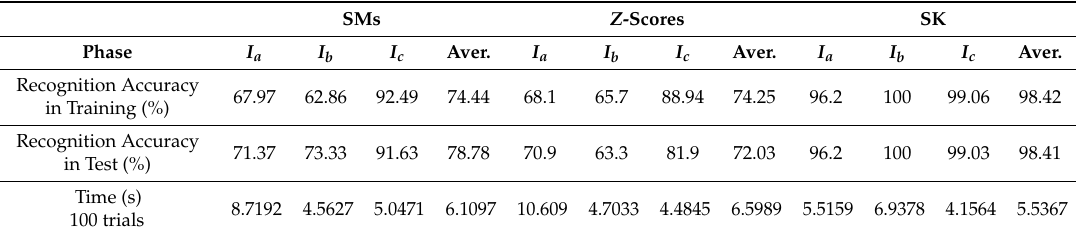
Table 8. Results of SLGF on the bus faults with the